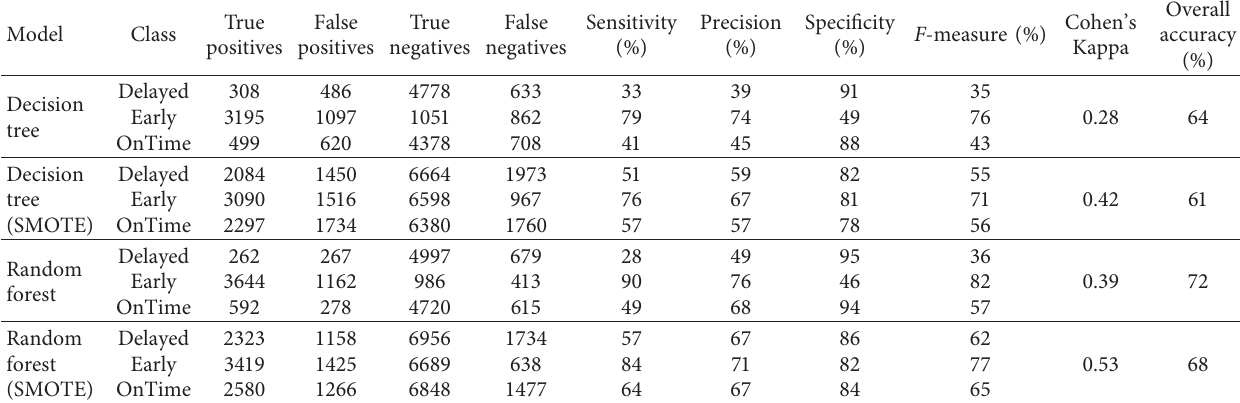
Table 4: Class statistics for all